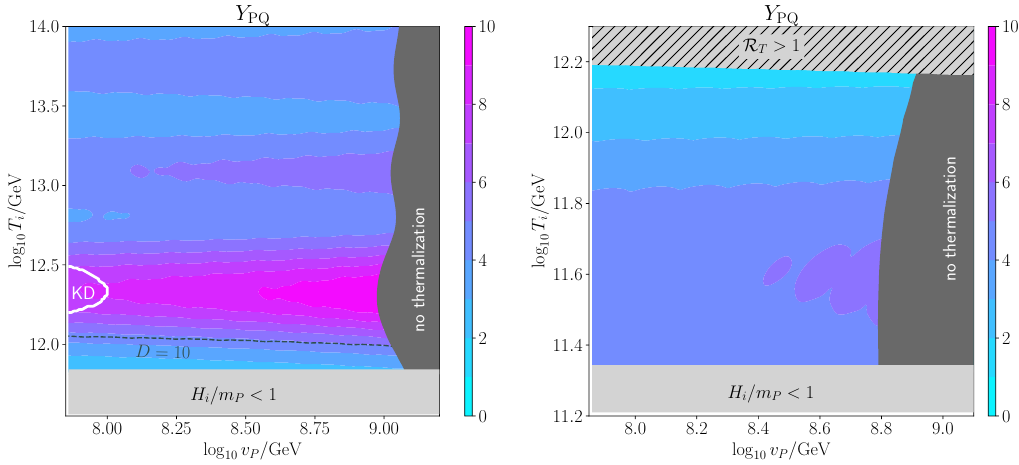
Figure 6 . Y PQ after dilution in the n = 10 , m P = 10 6 GeV ( n = 8 , m P = 10 5 GeV ) scenario on the left (right) panel. The dashed line is D = 10 and the KD era exists in the white line on the left